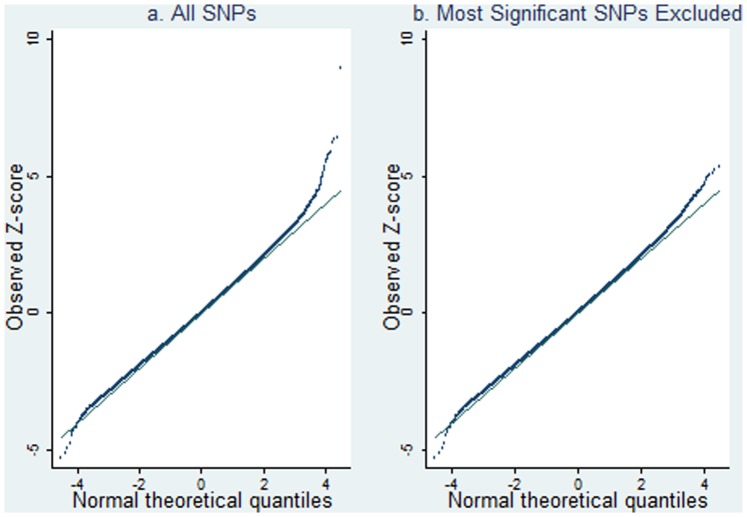
The QQ plot of observed Z-scores vs. expected Z-scores.The plot on the left side includes all 287,294 SNPs while the one on the right side excludes 8 SNPs with p-values smaller than 5×10−8.